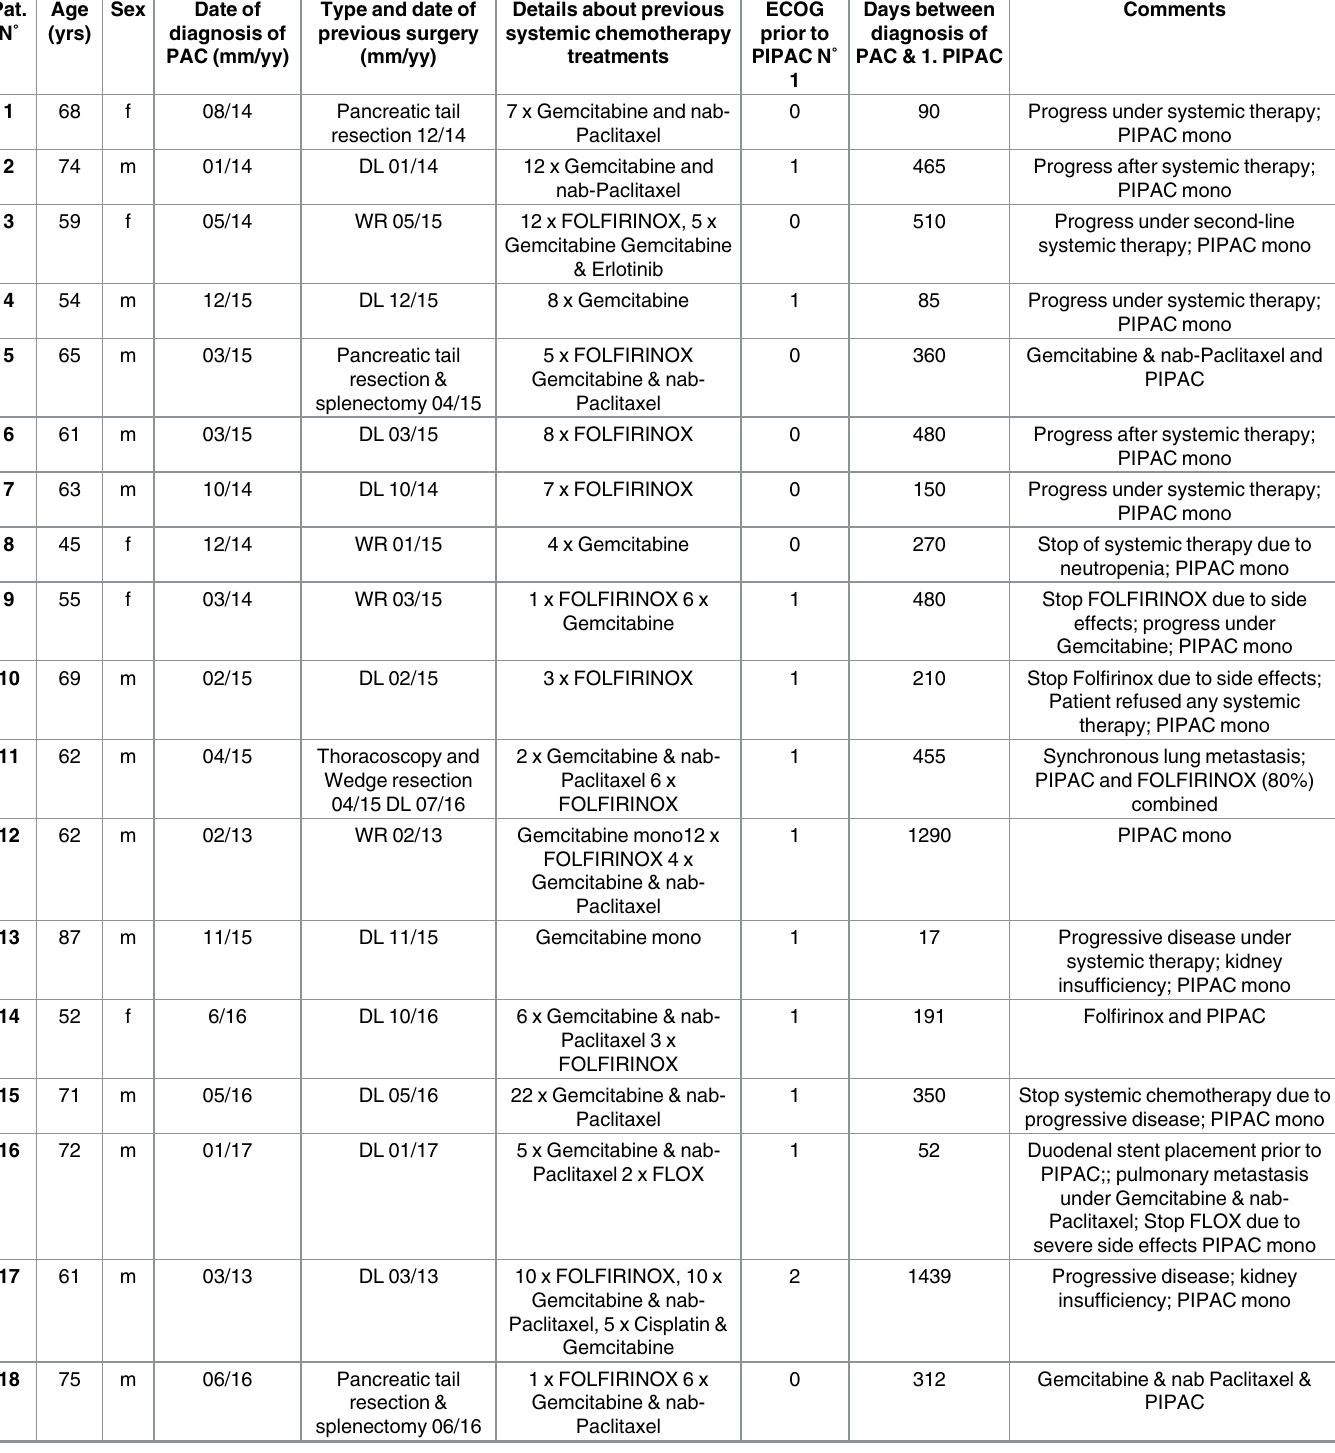
Table 1. Patient demographic and details on previous surgical interventions and systemic chemotherapy treatment before PIPAC. Pat.